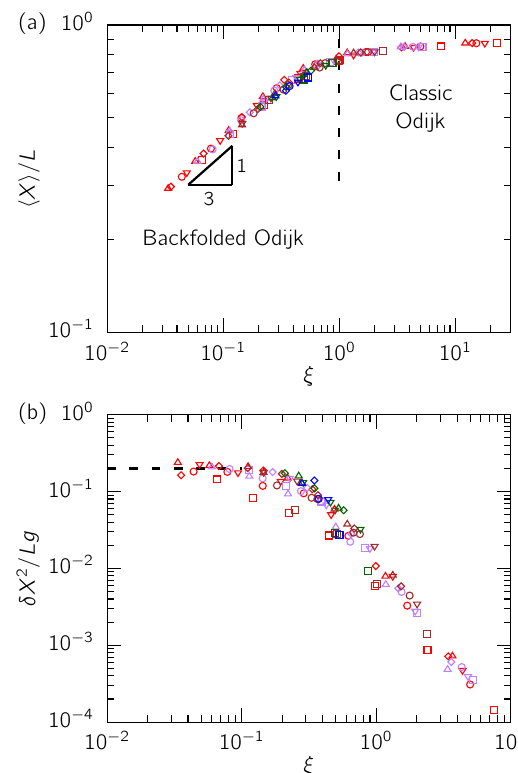
Figure 3. ( a ) Fractional extension against the scaling variable ξ . The vertical dashed line shows the boundary between the classic and backfolded Odijk regimes according to the scaling theory, ξ = 1. A power law fit to our data for ξ < 0.3 yields an exponent of 0.333 ± 0.007; ( b ) normalized variance of extension versus ξ . The horizontal dashed line corresponds to δ X 2 / Lg = 0.2. In both the panels, the L p / w values shown are L p / w = 10 ( (cid:3) ), L p / w = 12.5 ( (cid:53) ), L p / w = 15 ( (cid:13) ), L p / w = 17.5 ( (cid:5) ) and L p / w = 20 ( (cid:52) ). Different colors indicate different A eff / D eff ratios: red (1), purple (1.5), brown (2), green (3) and blue (4). All the data points satisfy the condition D eff ≤ A eff ≤ 2 L p